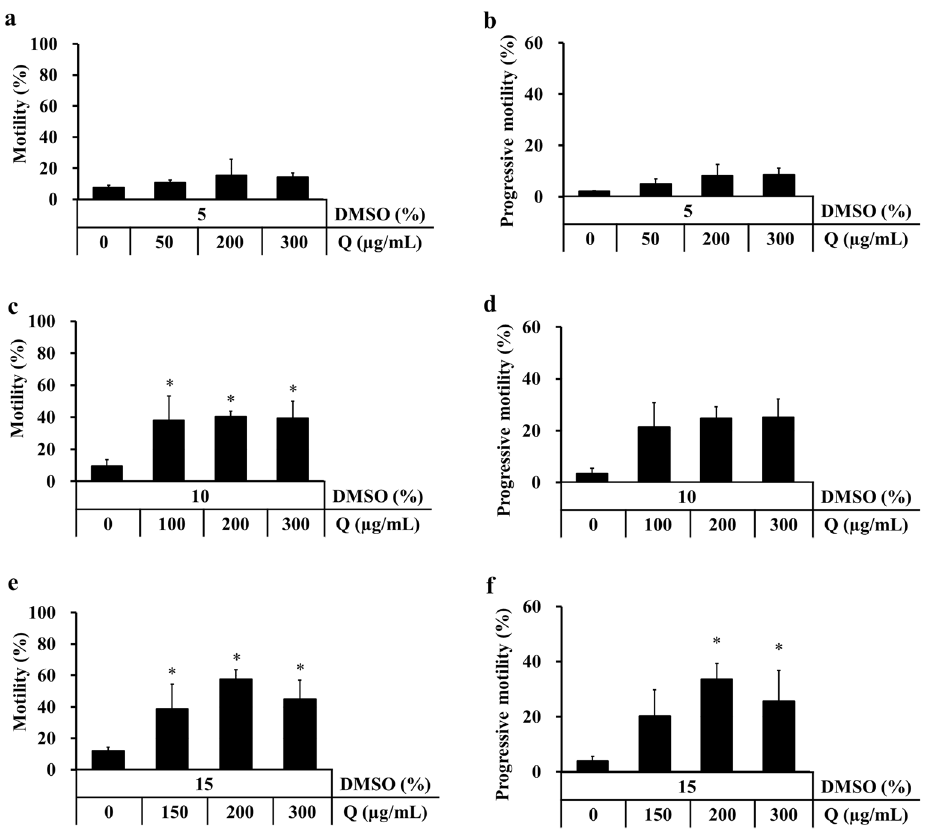
Figure 2. Effect of different concentrations of DMSO and quercetin (Q) on motility of cold-stored sperm. Cauda epididymides were cold-stored in Lifor with various concentrations of DMSO (5%, 10% and 15%) and quercetin (0, 50, 100, 150, 200 and 300 µg/mL) at 4 °C for 3 days. After cold-storage, sperm were cultured in mHTF for 2 h and motility was analysed using an IVOS sperm analyser. Motility was measured as the percentage of sperm moving at a speed of ≥ 5 µm/s ( a , c , e ). Progressive motility was measured as the percentage of sperm moving at ≥ 50 µm/s and progressiveness of > 50% ( b , d , f ). Results are expressed as mean ± SD (n = 3–5 male rats/group, 45 male rats were used).* P < 0.05 compared with 0 µg/mL quercetin in each